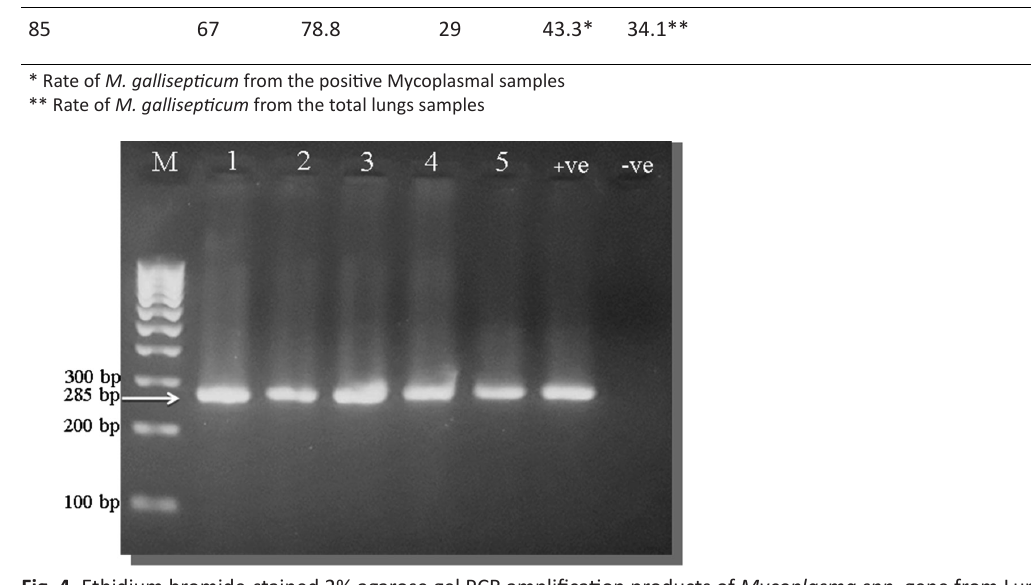
Fig. 4. Ethidium bromide-stained 2% agarose gel PCR amplification products of Mycoplasma spp . gene from Lung